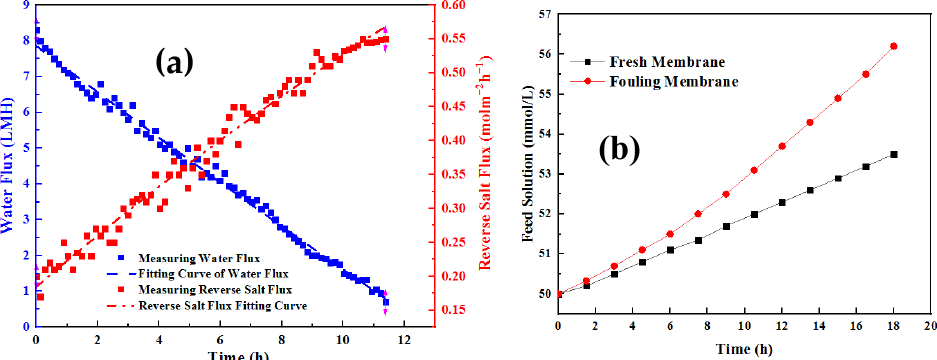
Figure 7. Experimental and simulation results of water flux and reverse salt flux during membrane fouling test ( a ) and the change trend of salt concentration in feed liquid with and without pollution calculated by the model ( b ).